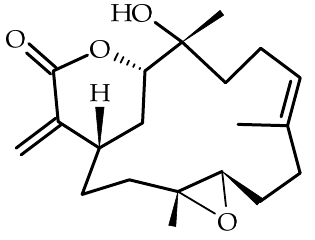
Figure 3. Chemical structure of sinularin.